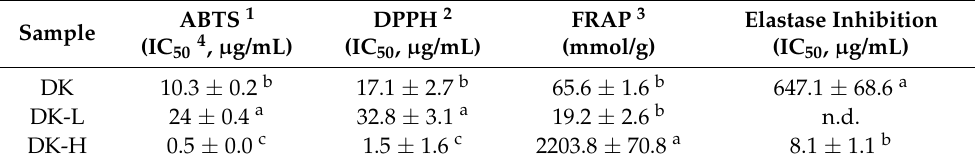
Table 3. Antioxidant and elastase inhibitory activities of D. kaki extract (DK) and its low- and high-molecular-weight fractions (DK-L and DK-H,